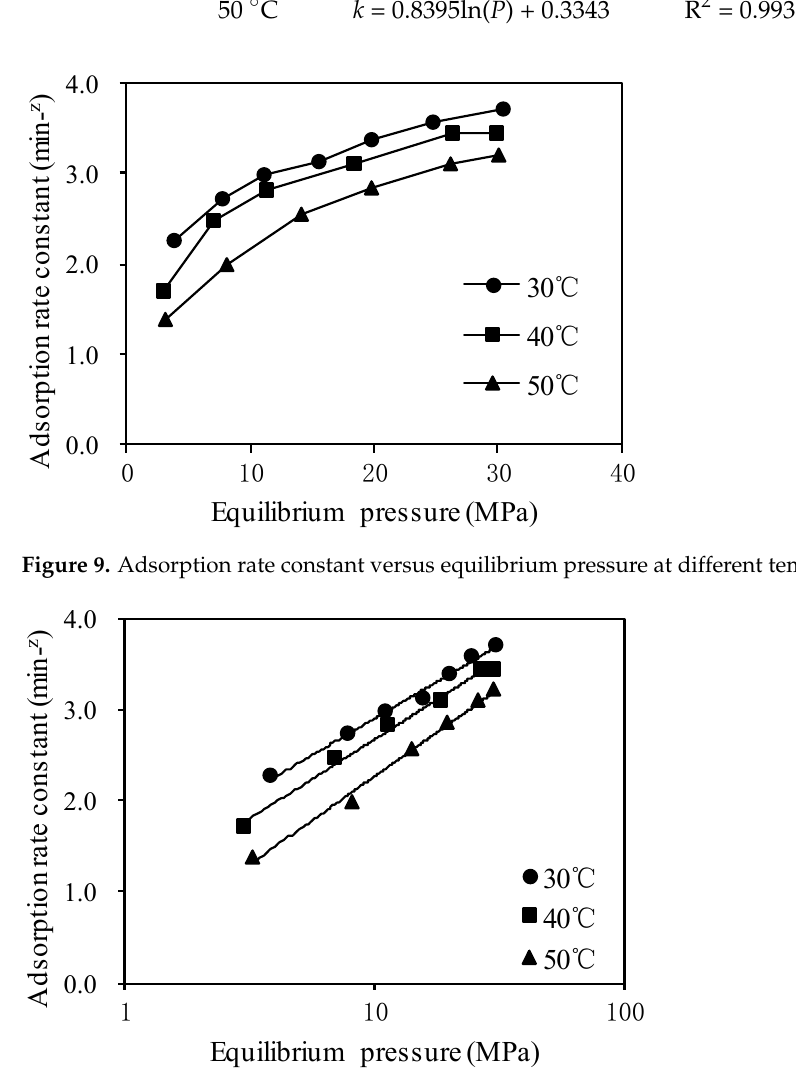
Figure 10. The relationship between adsorption rate constant and equilibrium pressure.